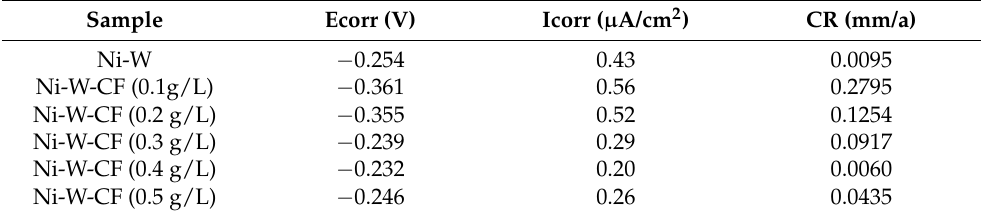
Figure 5. Polarization curves of Ni-W-CF composite coatings with different concentrations of CF.